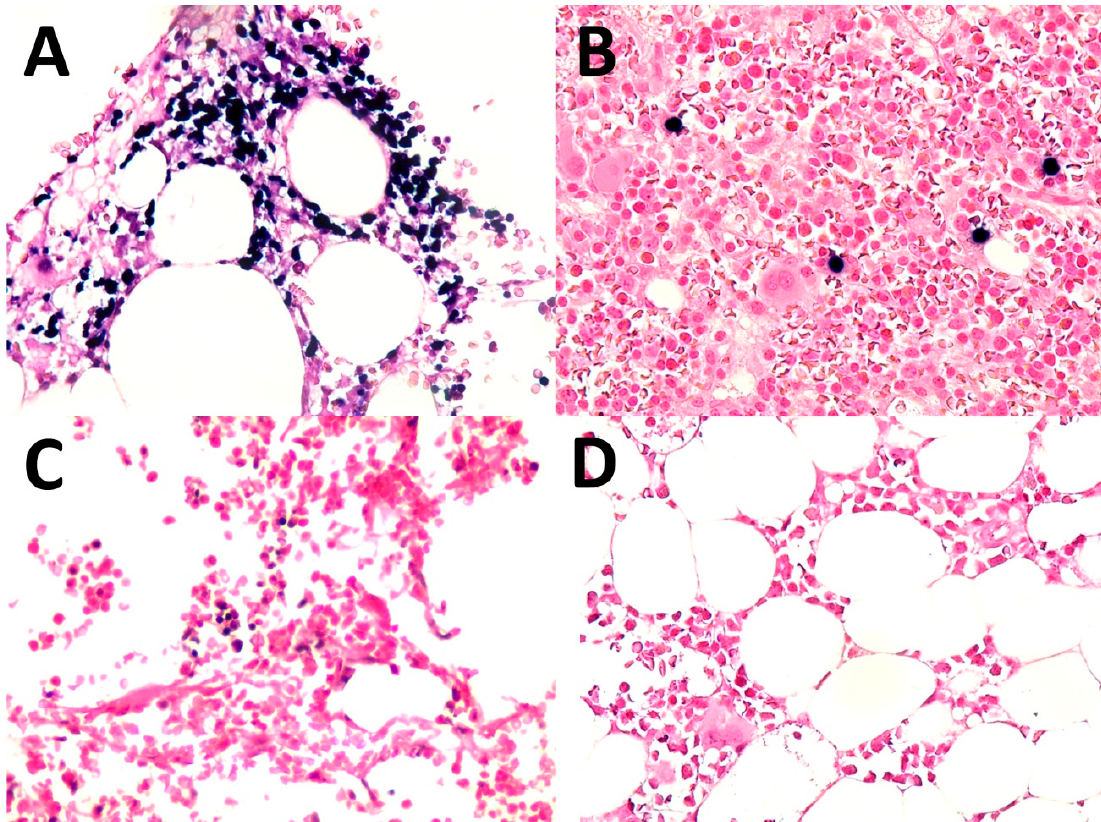
Figure 5. Bone marrow: ( A ) involved in ENK/T lymphoma, diffuse (EBV-encoded RNA in situ hybridization (EBER), original magnification ×400); ( B ) involved in ENK/T lymphoma, scattered cells (EBER, original magnification ×400); ( C ) scattered individual small lymphocytes with positive EBER (EBER, original magnification ×400); ( D ) negative for EBER+ cells (EBER, original magnification ×400).